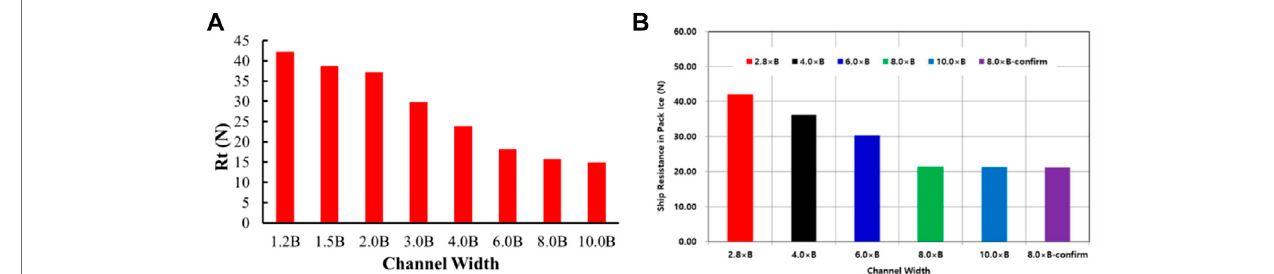
FIGURE 17 | In fl uence of channel width on ice